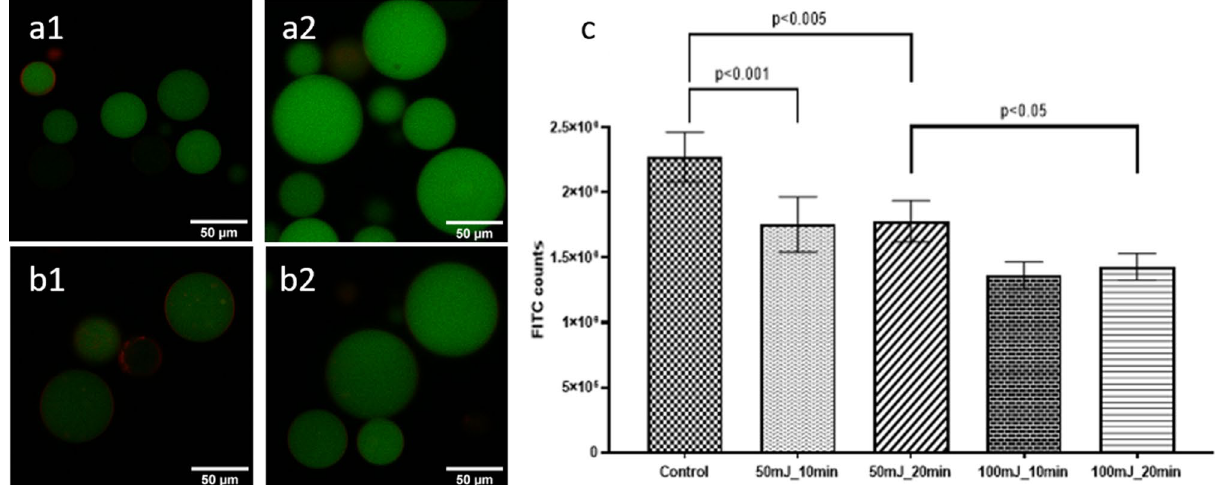
Figure 5. Confocal images and flow cytometry of GUVs containing FITC-dextran. ( a ) Representative examples of images of GUVs before exposure to photoacoustic waves, and ( b ) after exposure to photoacoustic waves ( b1 ) exposure to 50 mJ/cm 2 for 20 min; ( b2 ) exposure to 100 mJ/cm 2 for 10 min). ( c ) Flow cytometry counts of fluorescence intensity inside the GUVs before and after exposure to photoacoustic waves. Uncertainties in the results are indicated by error